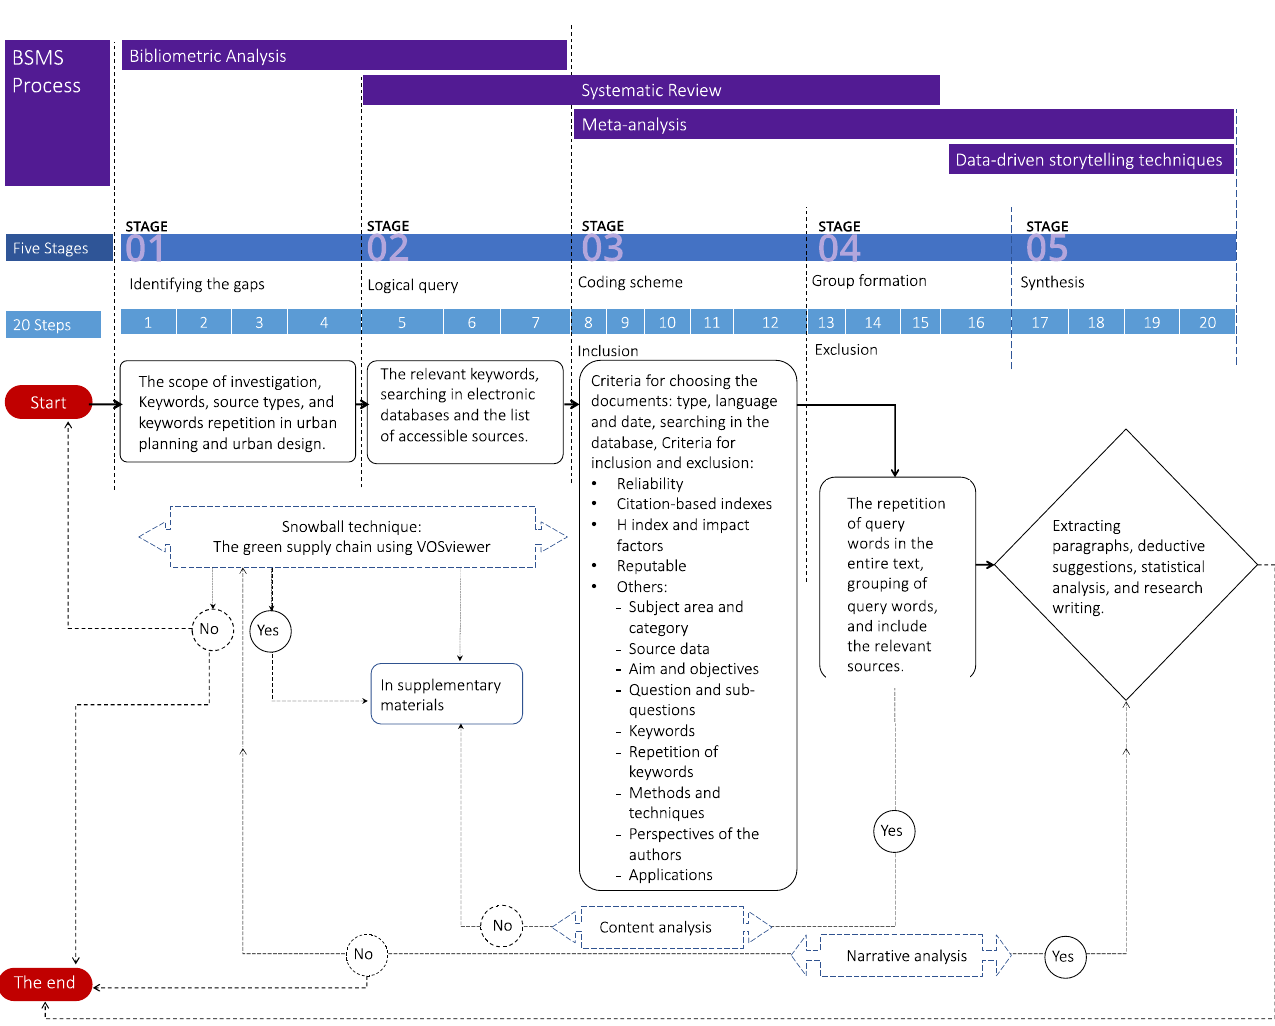
Figure 1. BSMS process in UP and